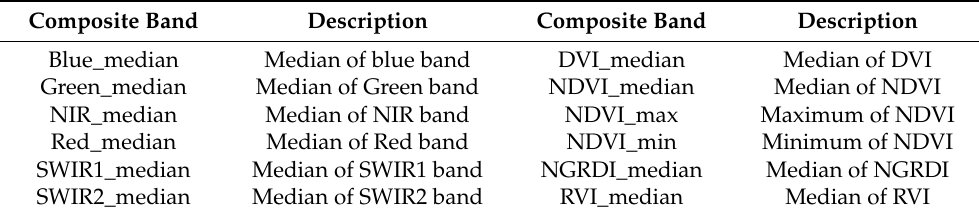
Table 2. Bands and indices that are included in each seasonal composite. Each of these components are treated as features in cover crop classification model.